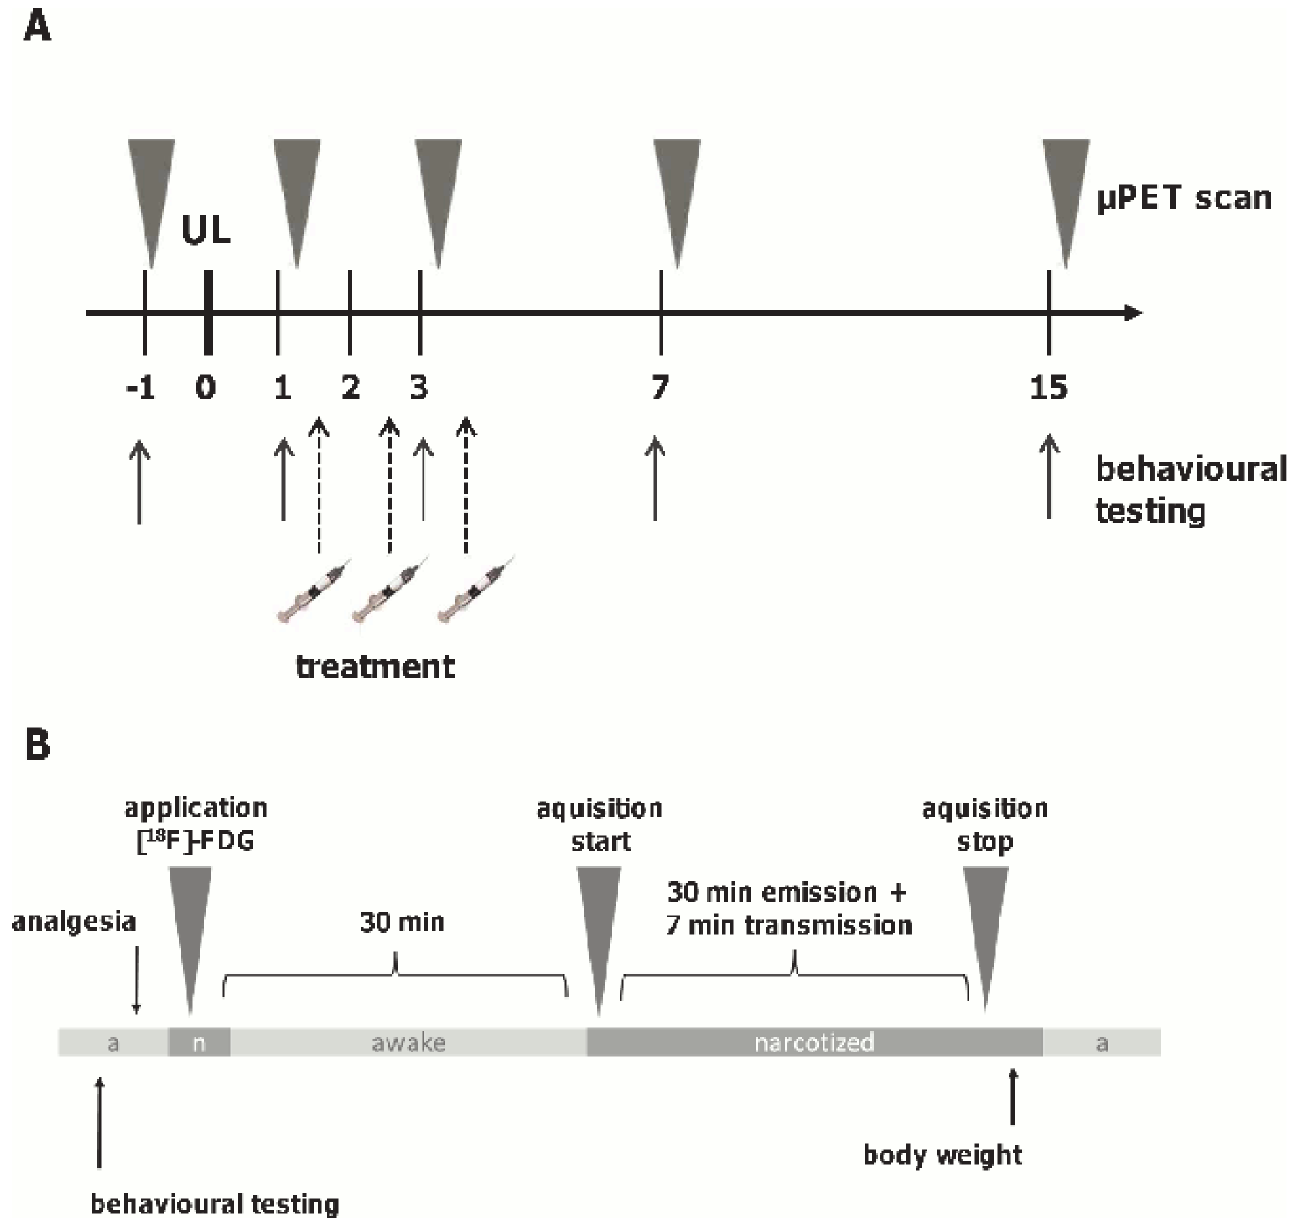
Fig 1. Study design and time course of treatment, μ PET scanning and behavioural testing. A) N-acetyl-DL-leucine, N-acetyl-L-leucine or N-acetyl-D- leucine was administered intravenously on days 1, 2 and 3 after unilateral labyrinthectomy (UL). Sequential whole-brain [ 18 F]-FDG- μ PET and behavioural testing was done before and on days 1, 3, 7, 15 after UL. B) At the respective time points after behavioural testing, anaesthesia was induced with isoflurane and [ 18 F]-FDG was injected. After awaking, animals were allowed to move freely until anaesthesia was induced again with isoflurane for the μ PET-scan. The scan was started 30 min after [ 18 F]-FDG injection. A 30-min emission recording was initiated followed by a 7-min transmission